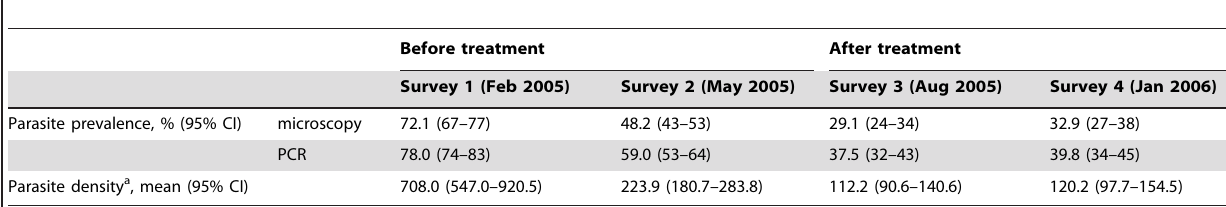
Table 1. Parasitological characteristics at three-monthly cross-sectional surveys.